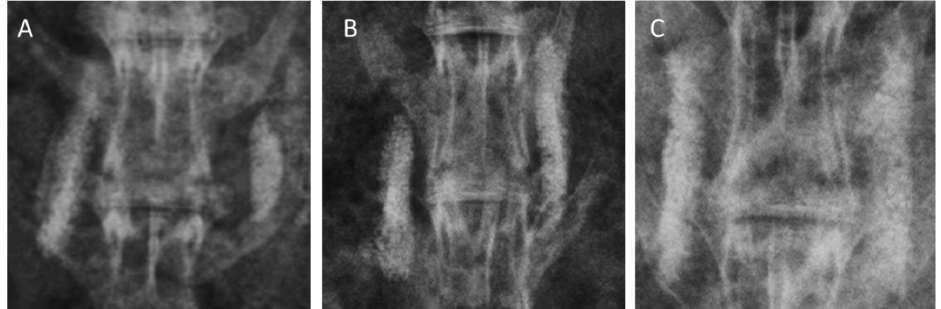
Figure 3. Radiographs of grafted materials in each group after 12 weeks of posterolateral fusion. ( A ) collagen- β -TCP-HA; ( B ) collagen- β -TCP-HA/BMDMSCs; ( C ) collagen- β -TCP-HA/Baculo-BMP-7-B